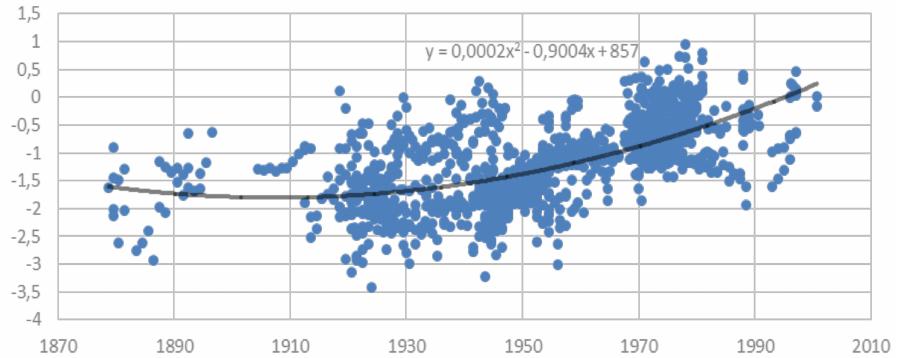
Figure 1. Height-for-Age Z scores (HAZ) of samples of Chilean boys and girls by birth cohorts (1877 − 2001), including a quadratic trend